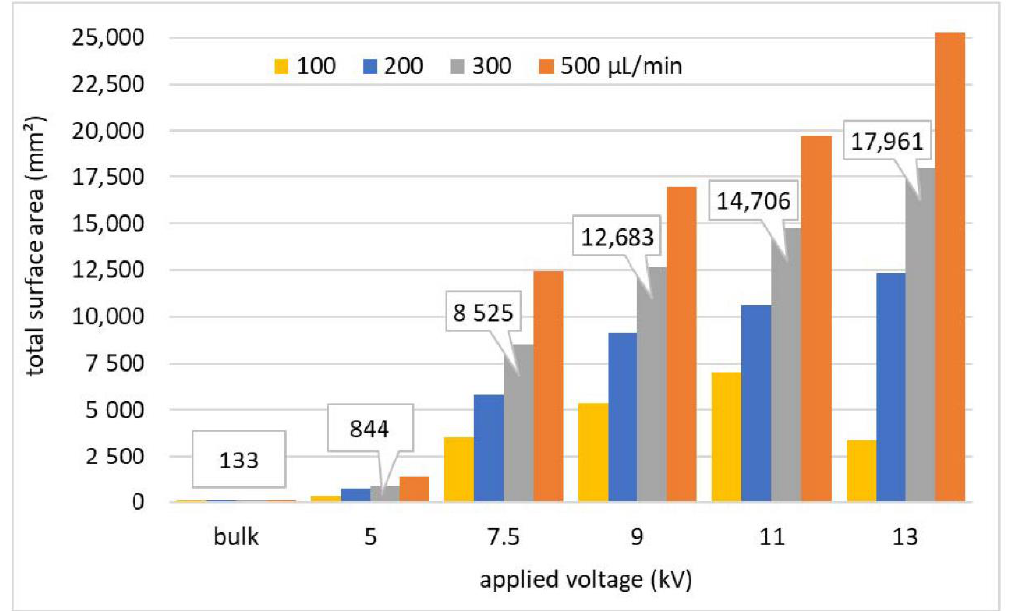
Figure 6. The total surface area of water droplets and microdroplets formed by ES during 1 min for different Q w ( µ L/min) as a function of V a (kV), compared to the bulk water experiment.